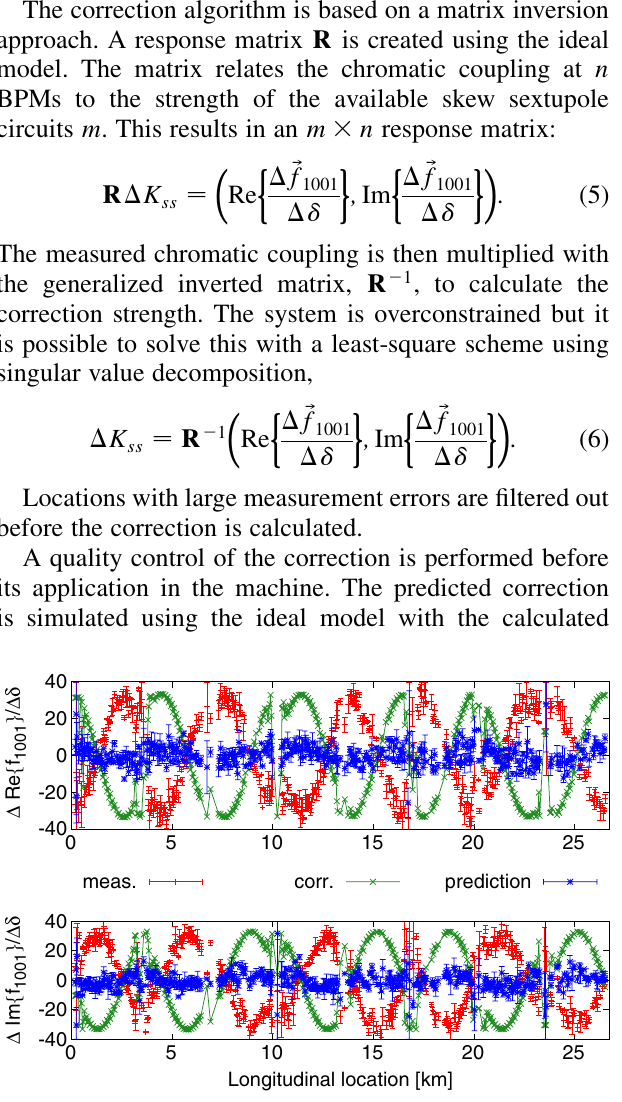
FIG. 4. The measured beam 1 chromatic coupling for different (cid:1) (cid:10) at 4 TeV.